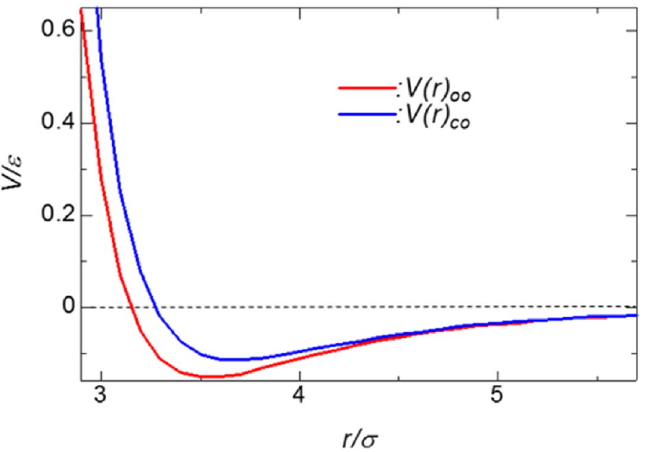
Figure 2. Theoretical curves of terms representing van der Waals interactions in the intermolecular force field of the potential function